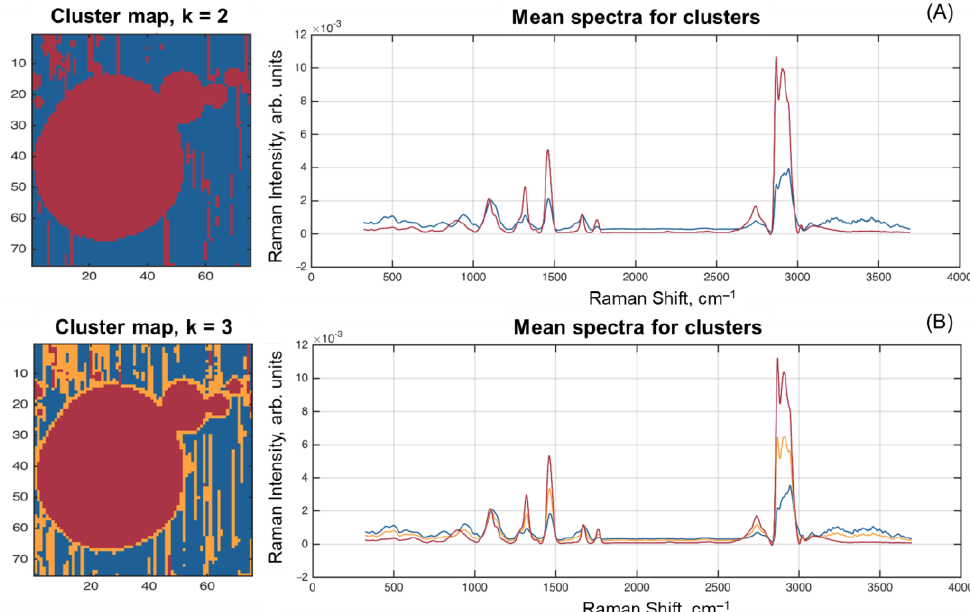
Figure 8. Spectrum clustering results for two ( A ) and three ( B ) clusters.